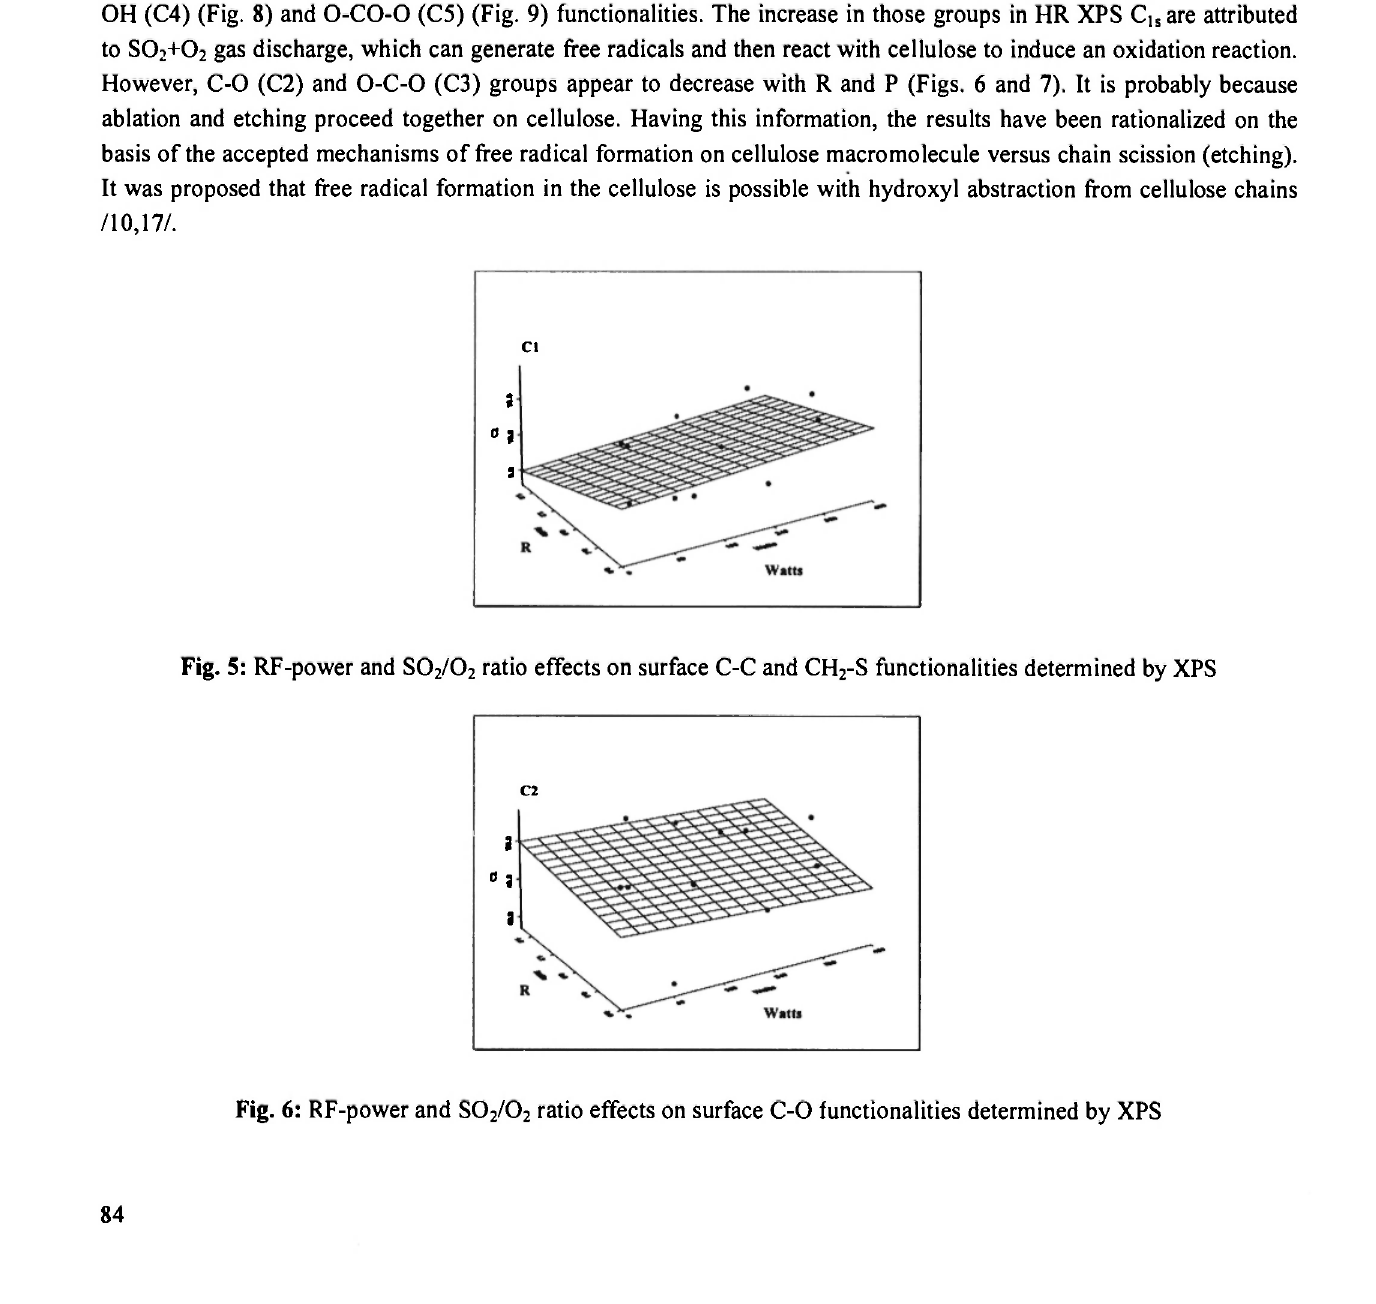
Fig. 6: RF-power and S0 2 /0 2 ratio effects on surface C-0 functionalities determined by